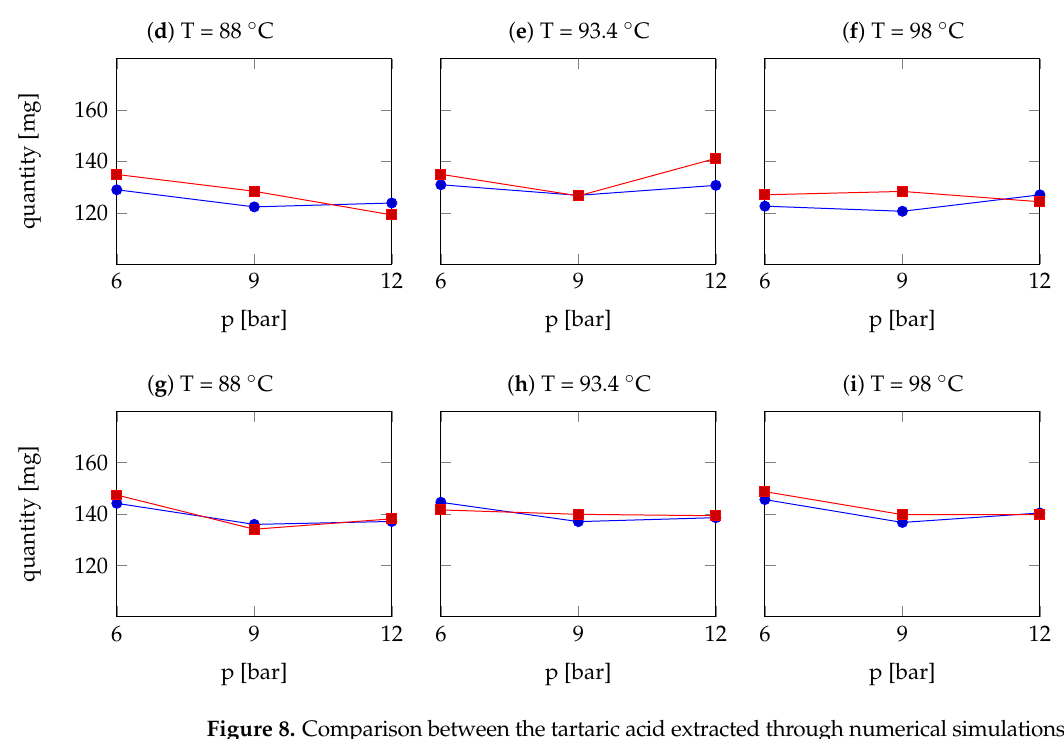
Figure 8. Comparison between the tartaric acid extracted through numerical simulations (blue profile with circles) and laboratory measurements (red profile with squares), with different inlet water tempera- tures and pressures and different grain size of Arabica coffee powder. Figures ( a – c ) show the results of optimal granulometry, Figures ( d – f ) of coarse granulometry and Figures ( g – i ) of fine granulometry.